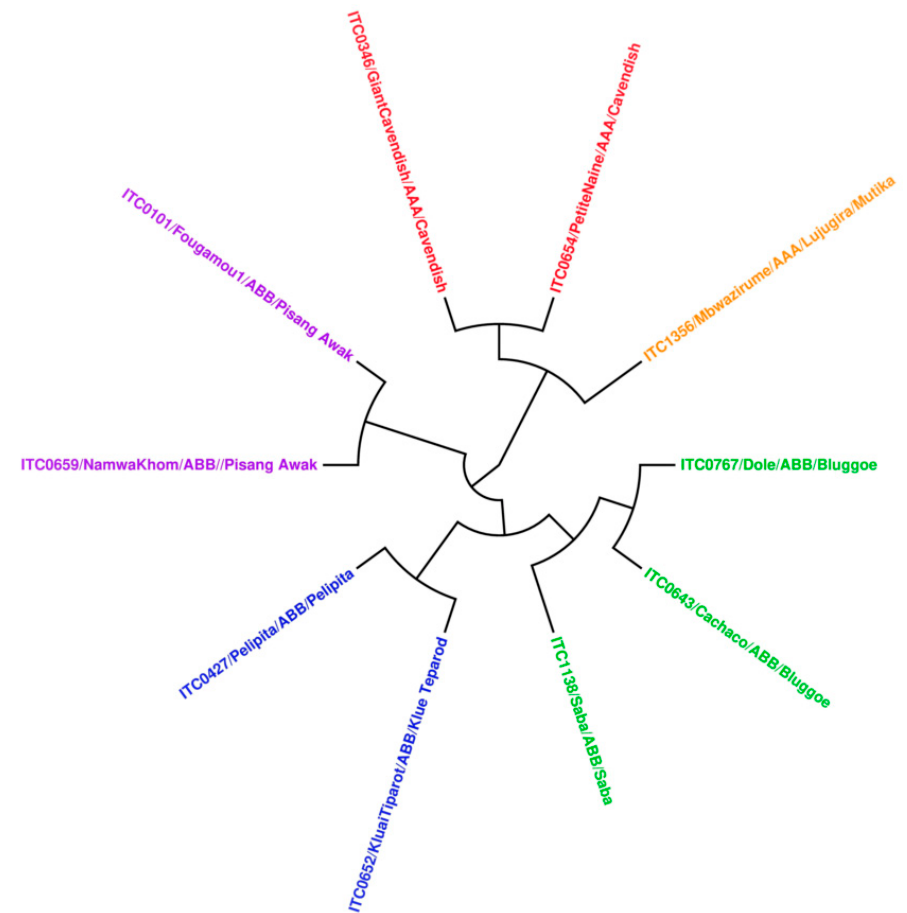
Figure 6. Construction of UPGMA dendrogram using all tested cultivars.